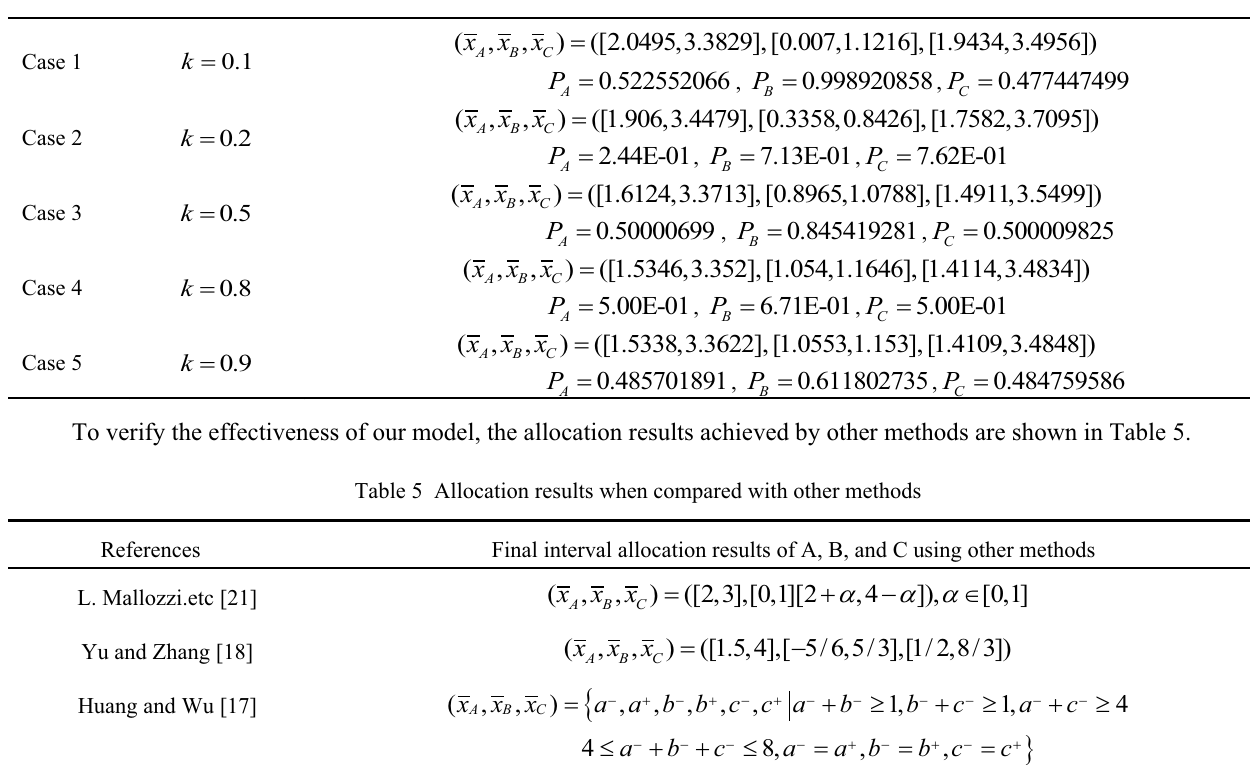
Table 4 Relatively optimal interval core based on desirability function No. Parameters Interval allocation results of companies A, B, and C and their desirability